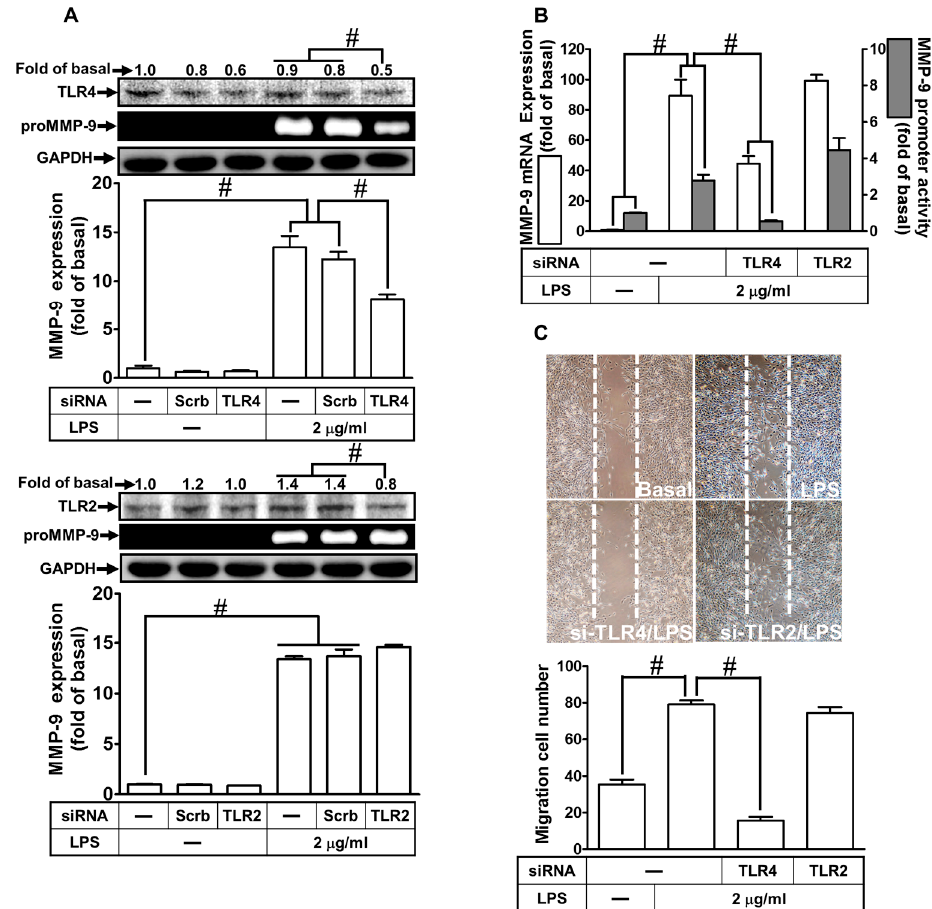
Figure 2. LPS induced the MMP-9 expression and cell migration via Toll-like receptor 4 (TLR4). ( A ) RBA-1 cells were transfected with scrambled (Scrb), TLR4, or TLR2 siRNA, and then incubated with LPS (2 µ g / mL) for 24 h. The levels of MMP-9 were determined by gelatin zymography. The GAPDH level of cell lysates was assayed by western blot. ( B ) Cells were transfected with TLR4 or TLR2 siRNA, and then incubated with LPS (2 µ g / mL) of 4 h for mRNA expression or 6 h for promoter activity. The mRNA expression and promoter activity of MMP-9 were determined by real-time PCR and promoter assay, respectively. ( C ) Cells were transfected with TLR4 or TLR2 siRNA and then incubated with LPS (2 µ g / mL) for 48 h. The number of cell migrations was determined (magnification = 40 × ). Data are expressed as mean ± SEM of three independent experiments. # p < 0.01 as compared with the cells exposed to vehicle or LPS, as indicated.